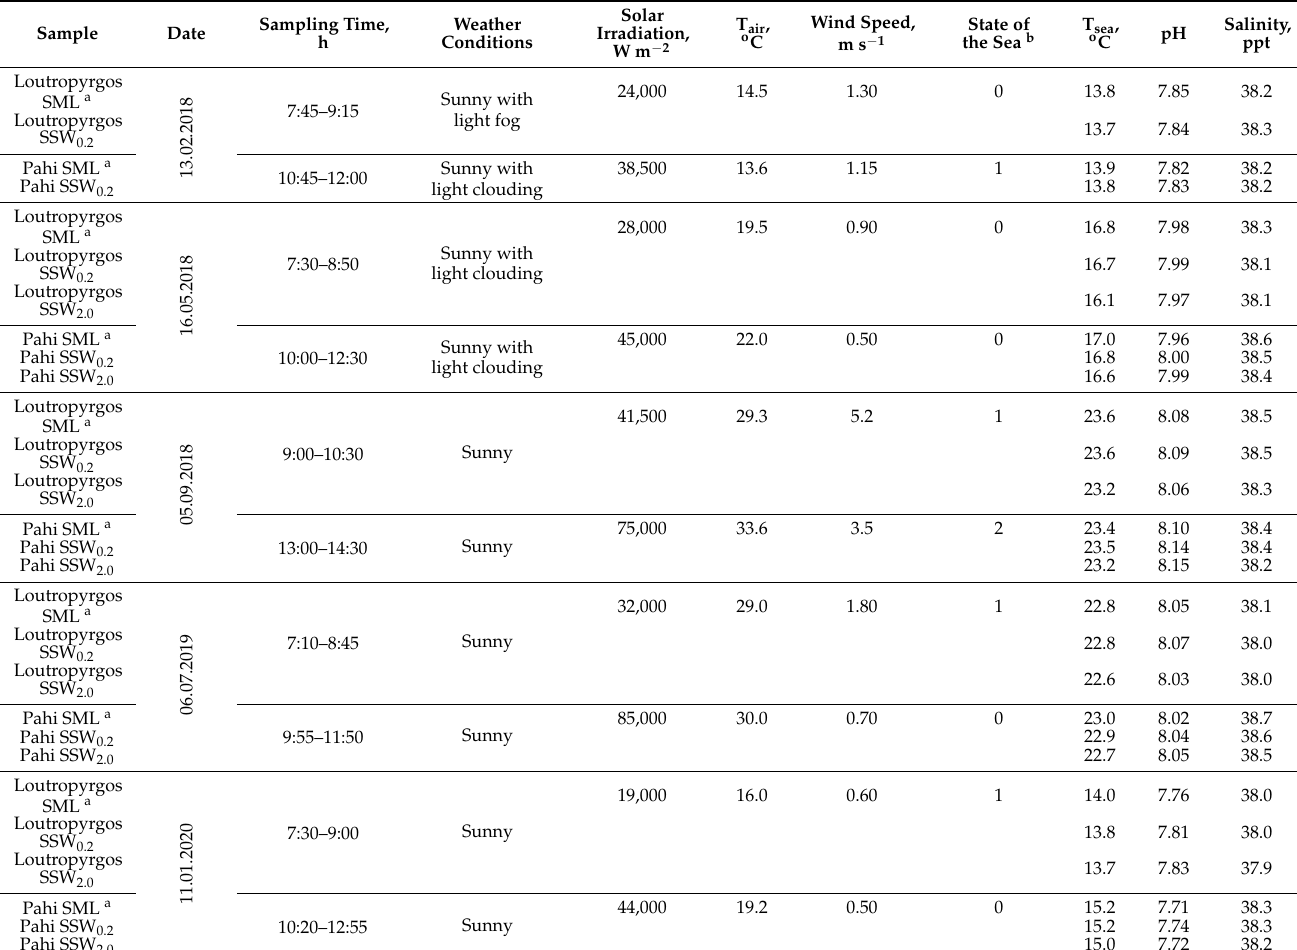
Table 1. Sampling dates, and environmental and physicochemical